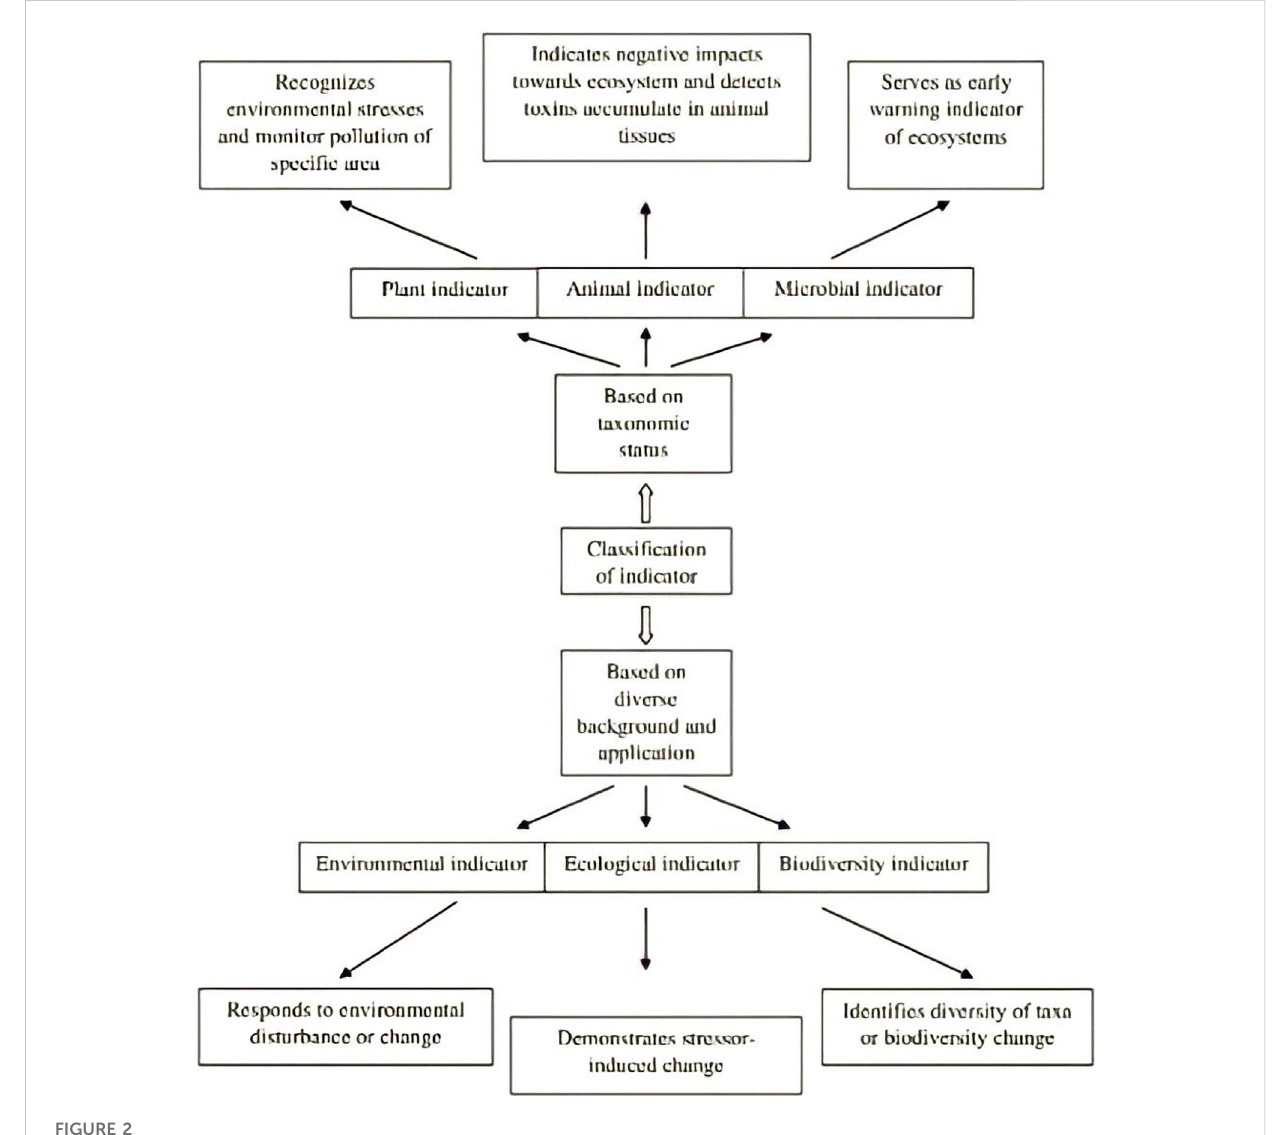
FIGURE 2 Classi fi cation of